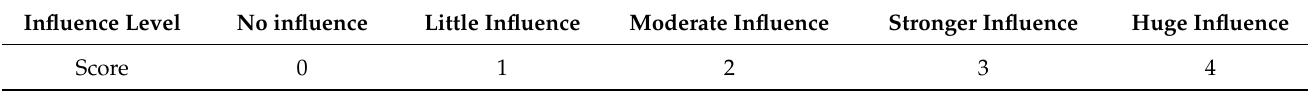
Table 1. Judgment basis of impact